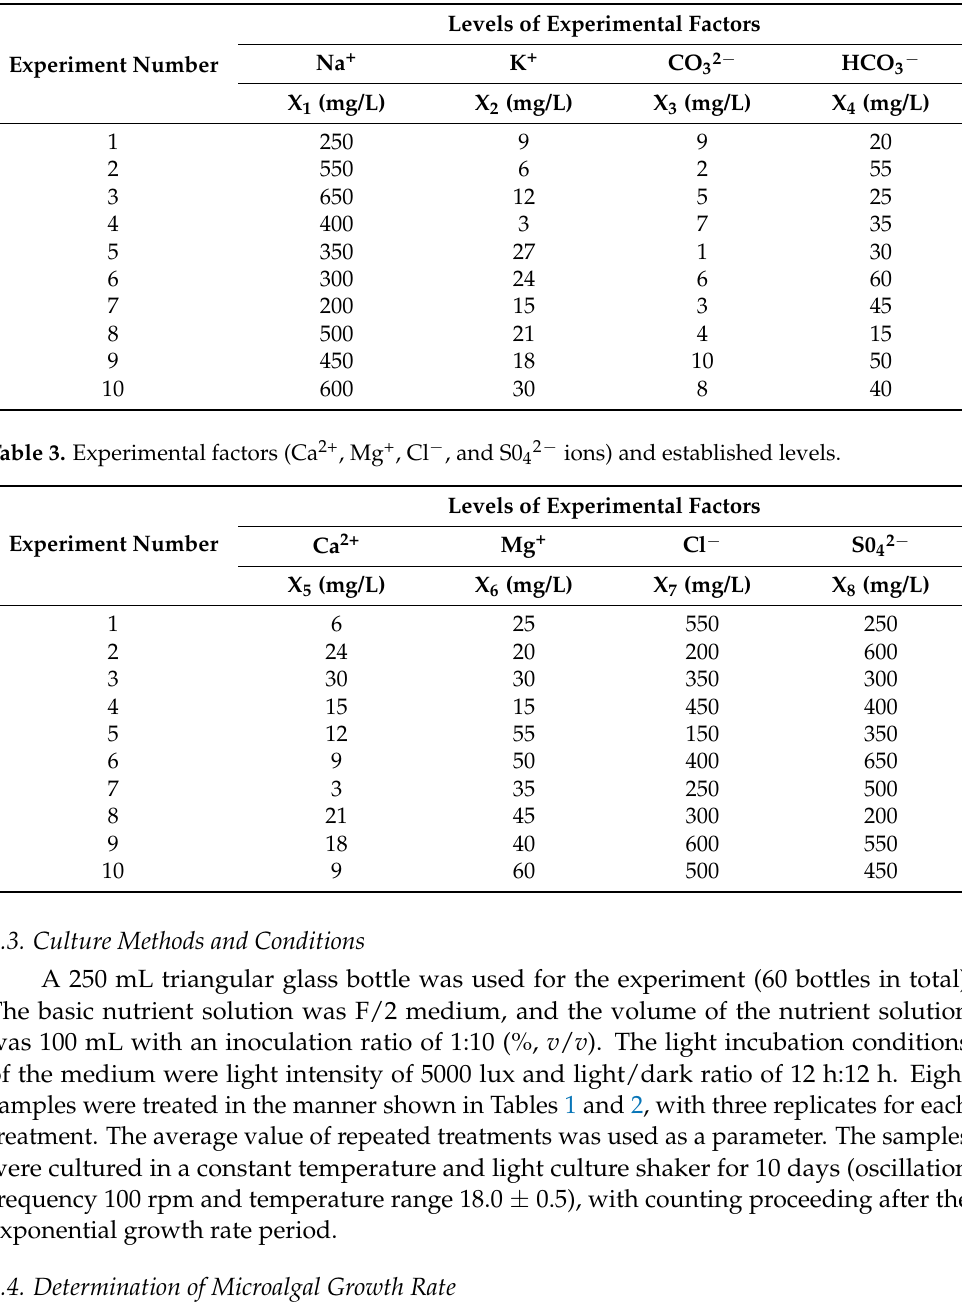
Table 2. Experimental factors (Na + , K + , CO 32 − , and HCO 3 − ions) and established levels.